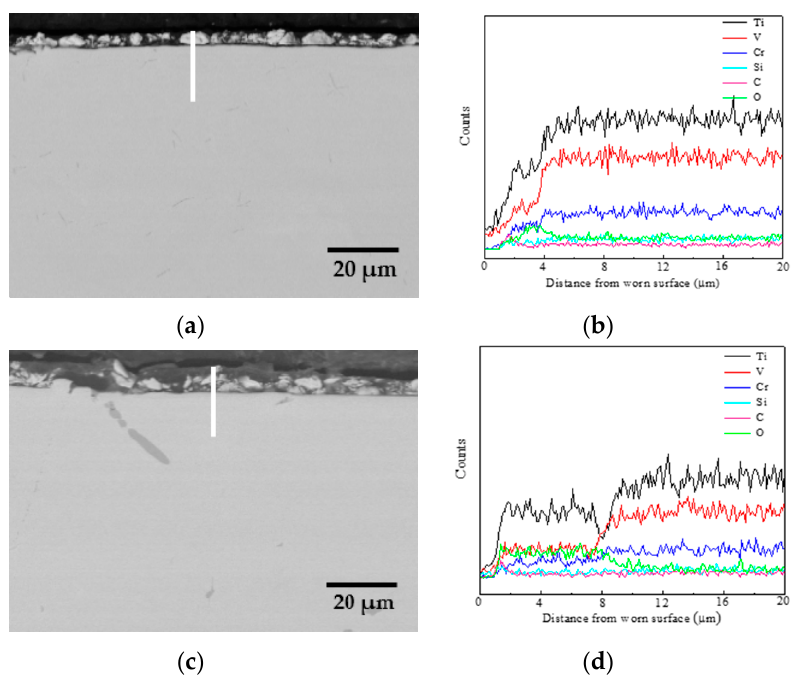
Figure 10. SEM cross-section morphologies and EDS line-analyses of the worn surface in TF550 alloy after wearing at high temperatures. ( a ) backscattered electron image (BEI) at 873 K; ( b ) compositions along the white line at 873 K; ( c ) BEI at 1073 K; and ( d ) compositions along the white line at 1073 K.